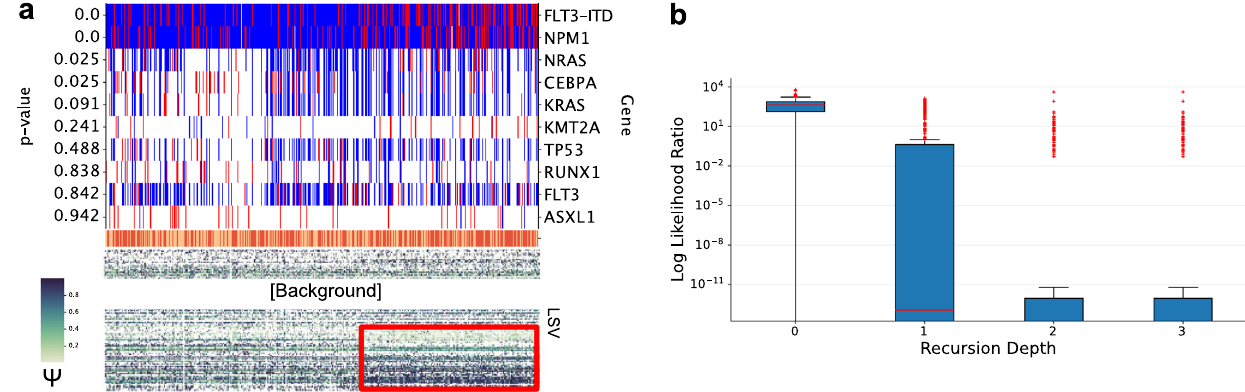
Fig. 4 | Recursive Clustering Analysis. a Heatmap showing CHESSBOARD clus- tering results after the fi rst recursive step. A single tile (samples=196, LSVs=389) was identi fi ed. The tracks above the heatmaps indicate whether a patient was positive(red)ornegative(blue)foreachmutation.Missingannotationsaremarked by white. The p values were computed using fi sher ’ s exact test for enrichment and corrected for multiple testing using the min-p method to account for missing annotations. b Boxplots showing the likelihood ratio distributions of LSVs after eachrecursivestep.Eachboxplotrepresentsarecursivestepwith0beingthebase